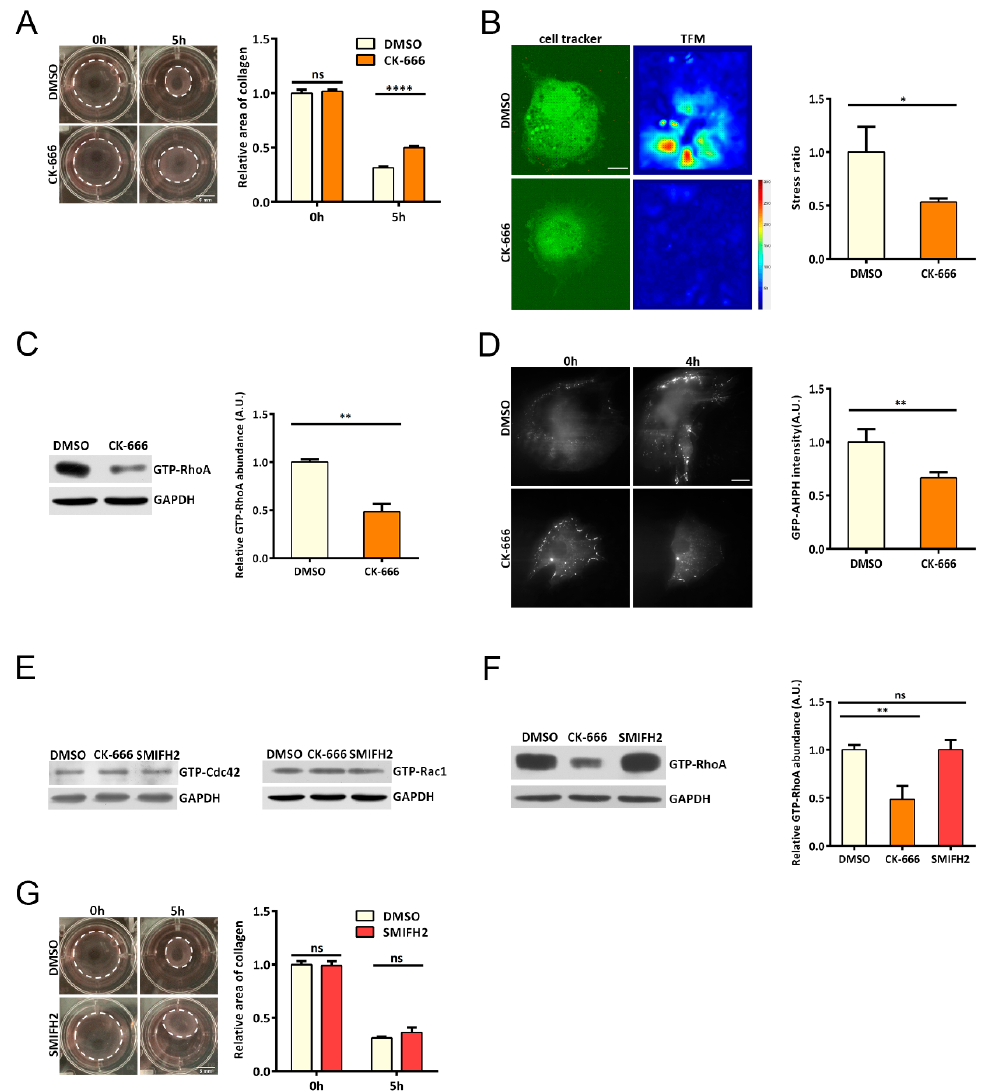
Figure 1. Arp2/3-branched actin maintains an active pool of the small GTPase RhoA. ( A ) Images showing gel deformation at 0 h or 5 h: Mouse embryonic fibroblasts (MEFs) were seeded in 1% collagen gel as indicated, and cells were treated with DMSO or the Arp2/3 inhibitor CK-666. Scale bar: 5 mm, error bar indicates SEM, n = 3 independent experiments. **** p < 0.05, by student’s t test. ( B ) Traction force microscopy (TFM) images showing beads displacement driven by mouse embryonic fibroblasts (MEFs) treated with DMSO or CK-666. Scale bar is 10 µm, n DMSO = 4, n CK-666 = 5. * p < 0.05, by student’s t test. ( C ) Western blot showing GTP-RhoA level in MEFs treated with DMSO or CK-666 for 5 h: GAPDH was used as loading control, error bar indicates SEM, and n = 3 independent experiments. ( D ) Representative images of MEFs expressing GFP-AHPH treated with DMSO or CK-666 for 0 or 4 h: scale bar is 10 µm, error bar indicates SEM, and n > 6 cells, ** p < 0.05. ( E ) Western blot showing GTP-Rac1 and GTP-Cdc42 levels in MEFs treated with DMSO or CK-666 for 5 h. ( F ) Western blot showing GTP-RhoA in MEFs treated with DMSO or SMIFH2: error bar indicates SEM, n = 3 independent experiments, and ns is no significant difference. ( G ) Images showing gel deformation at 0 h or 5 h. MEFs were seeded in 1% collagen gel as indicated, and cells were treated with DMSO or the formin inhibitor SMIFH2. Scale bar: 5 mm, error bar indicates SEM, n = 3 independent experiments. ns, no significant